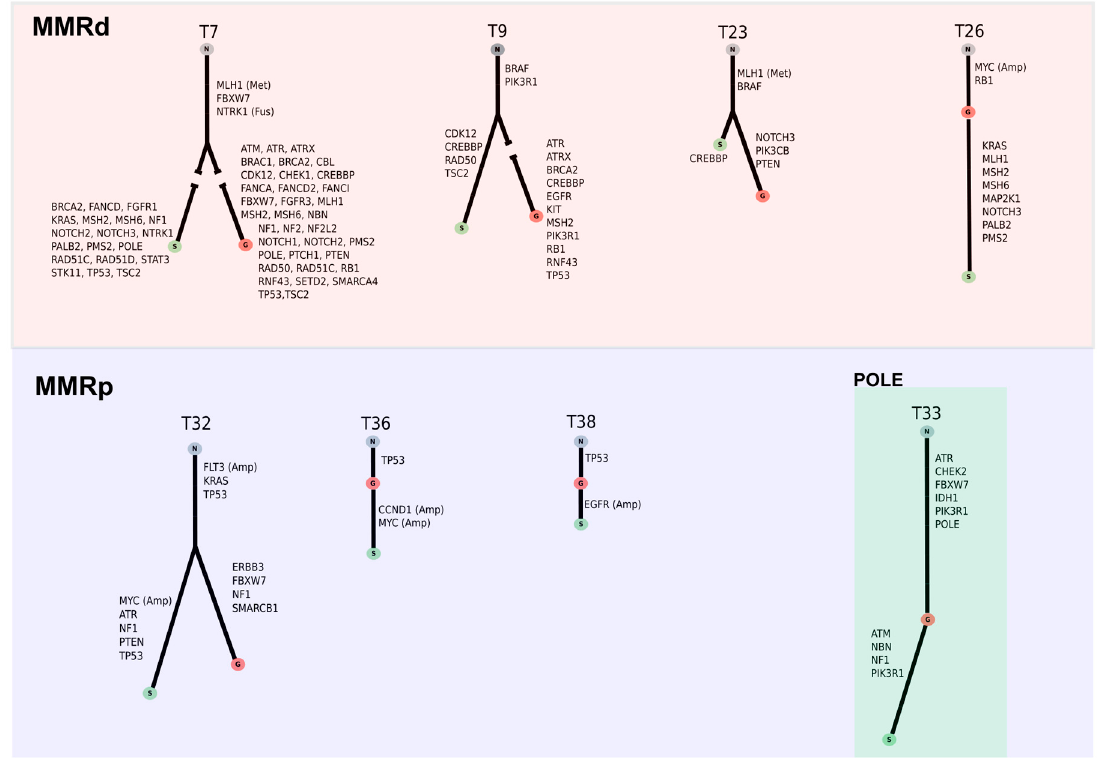
Figure 3. Evolutionary trees of different high-grade colorectal carcinomas that had both solid and glandular areas. The length of the branches is proportional to the number of mutated genes in each sample.